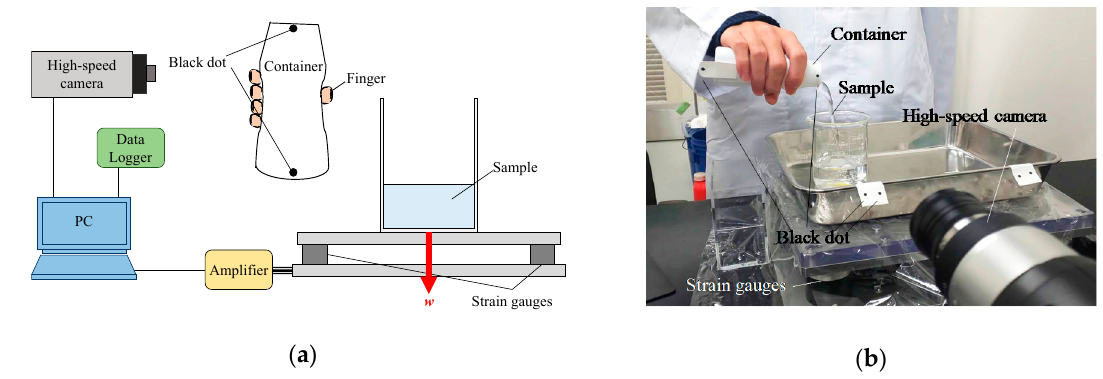
Figure 1. Pouring process observation system. ( a ) Conceptual diagram; ( b ) Image of the evaluation system. The red allow with w means the weight of sample.